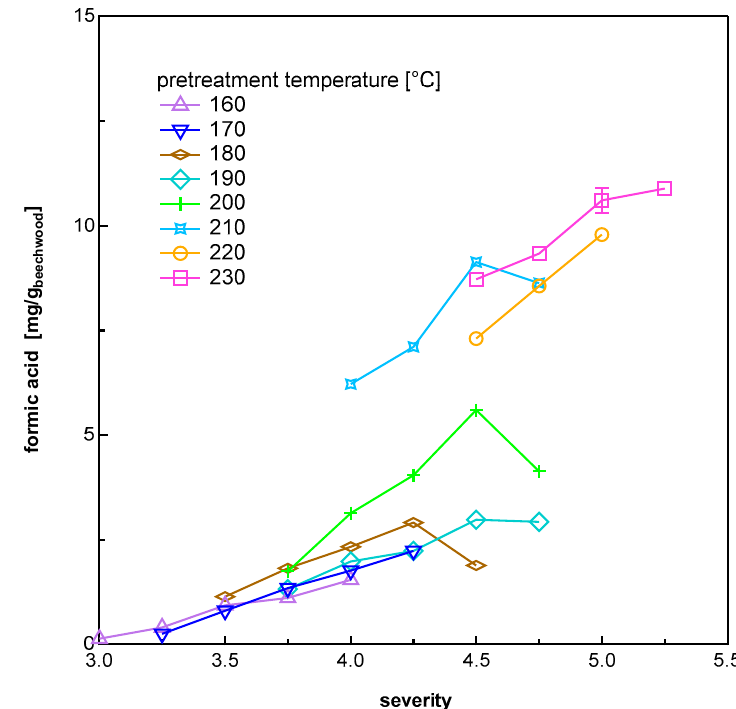
Figure 5. Formation of formic acid during steam explosion pretreatment. The amount of formic acid that is released into the prehydrolyzate during steam explosion pretreatment is shown as a function of the pretreatment severity and temperature.